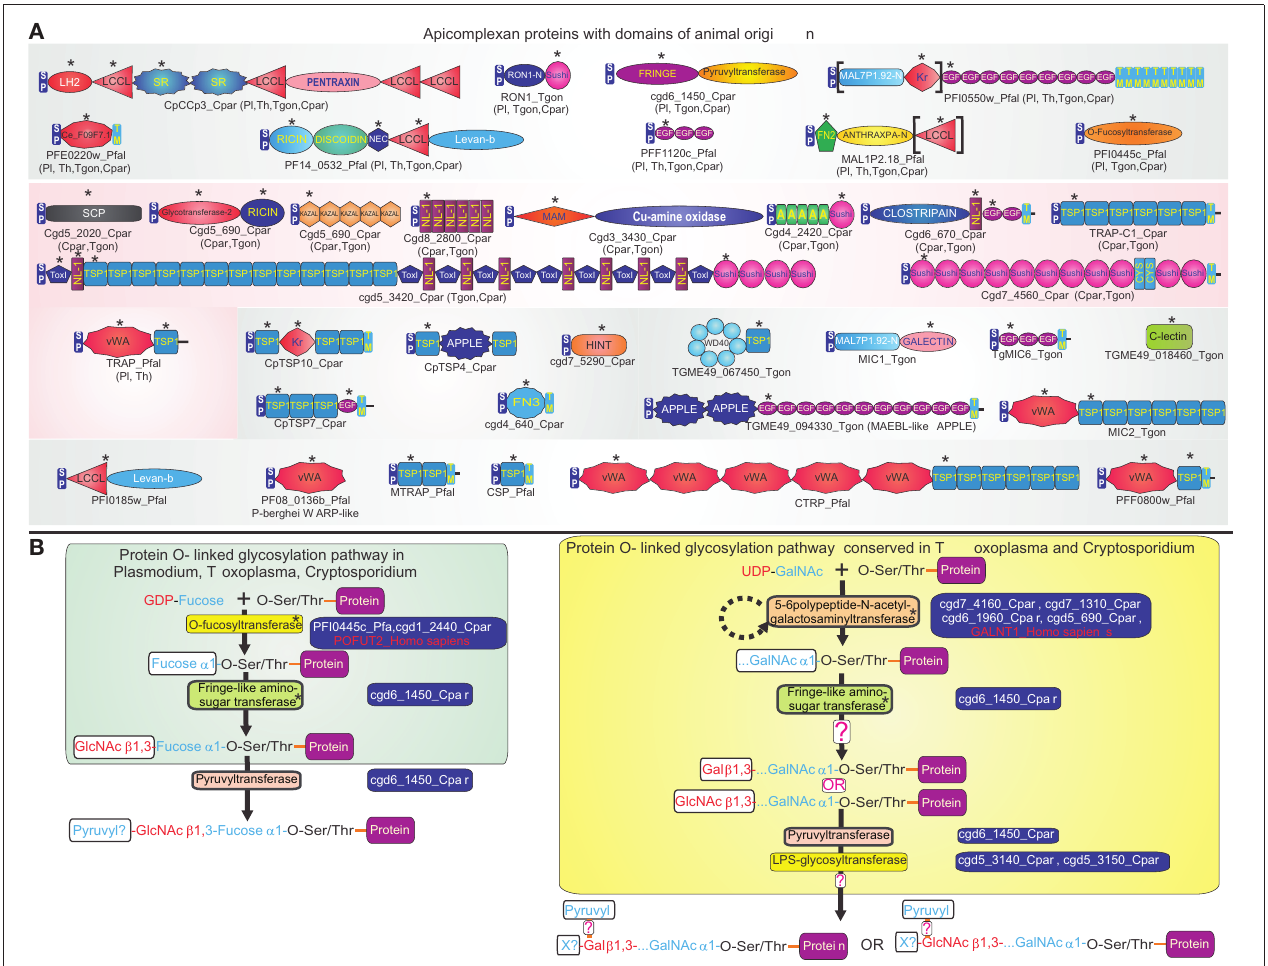
FIGURE 1 | Animal domains and animal-type O-glycosylation systems in apicomplexa. (A) Domain architectures of apicomplexan proteins containing adhesion domains of animal origin. Proteins are labeled by their gene names/common names and species abbreviation separated by an underscore, and are grouped based on their conservation in apicomplexans. If a domain architecture is present in more than one distinct apicomplexan lineage, the additional lineages are shown in brackets. Domains of animal origin are marked with an asterisk above the domain. If a domain is present in multiple copies in a protein, only one (the first) instance of it is labeled with an asterisk. Domains not present in all orthologs of a protein are enclosed in square brackets. Standard abbreviations are used for domains. Species